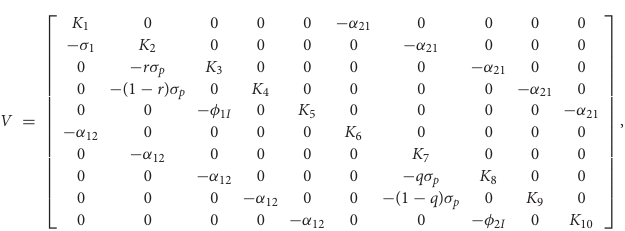
TABLE 3 | Estimated (fitted) parameter values and their 95 % confidence intervals for the model (2.5)–(2.6) in the absence of vaccination, using COVID-19 mortality data for the U.S. for the period from October 12, 2020 to January 20,